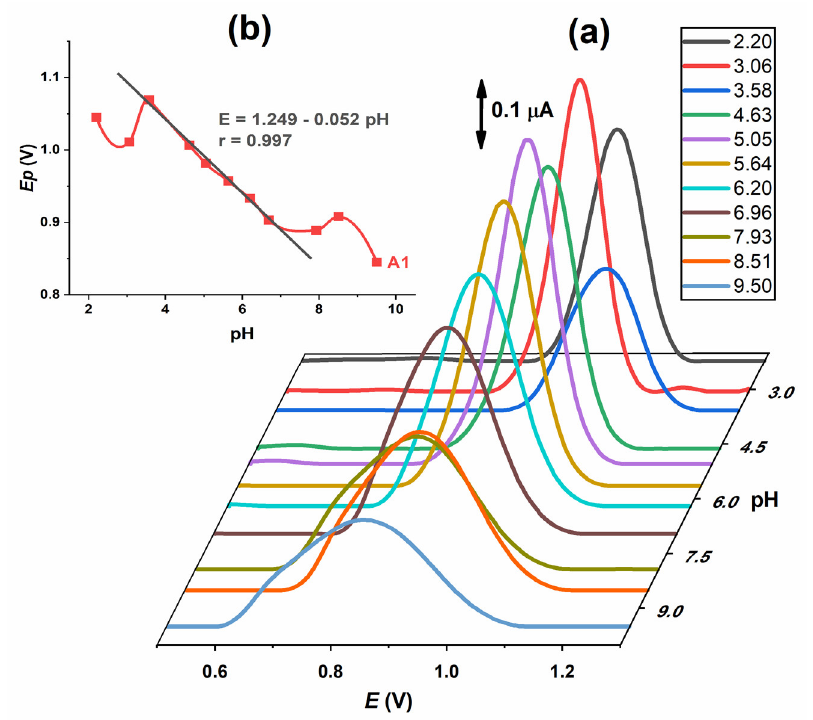
Figure 4. ( a ) 3D plot of DP voltammograms of 0.2 mmol L − 1 IVM recorded at different pH values. ( b ) Plot of E p vs. pH for oxidation A1 peak.